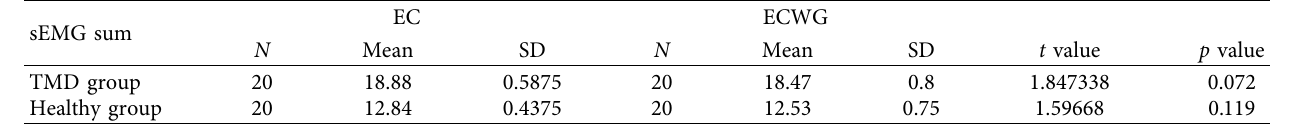
Table 5: EMG values with eyes closed with and without glasses on.